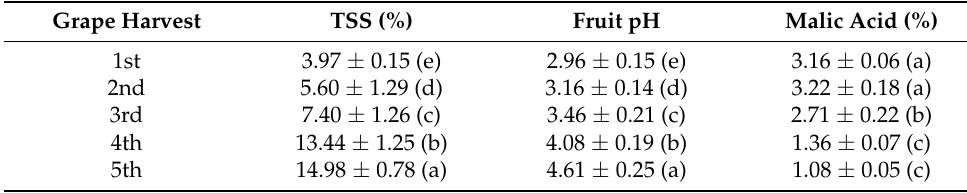
Table 1. Physiological parameters of harvested fruits.